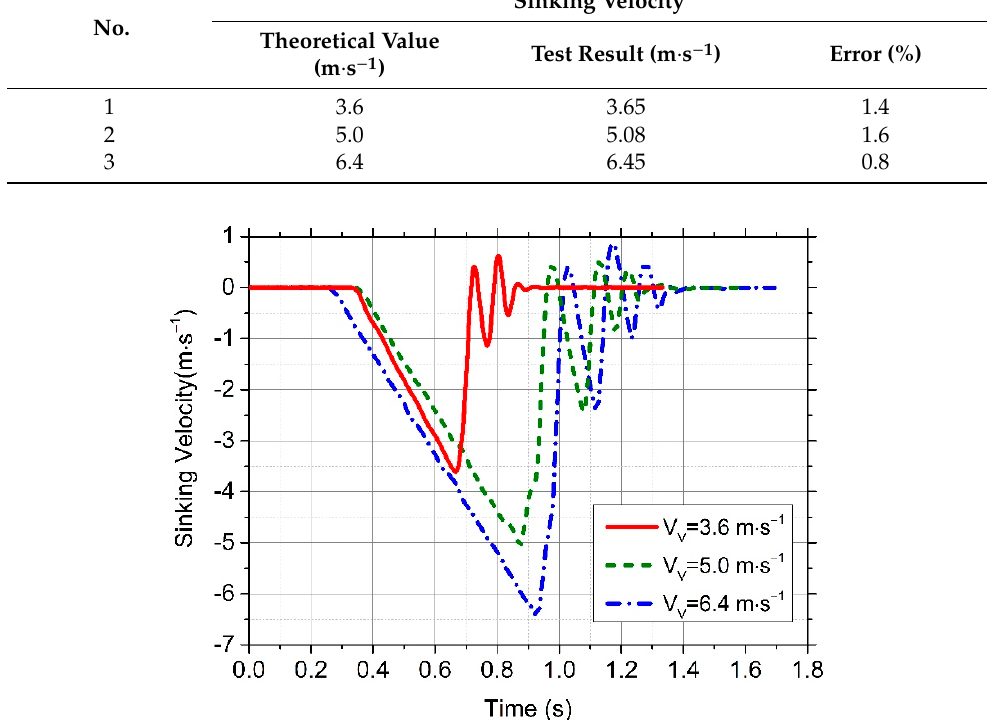
Figure 15. Control cabinet and display.